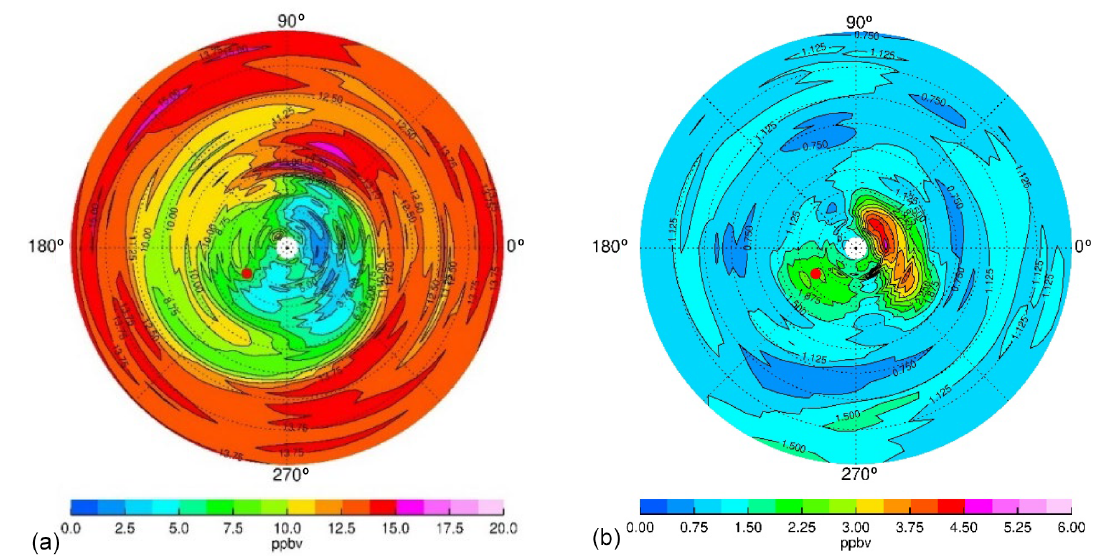
Figure 10. (a) Nighttime NO 2 on 27 January at 4.6hPa; CI is 1.25ppbv. (b) HNO 3 at 4.6hPa; CI is 0.375ppbv. Red dot is Poker